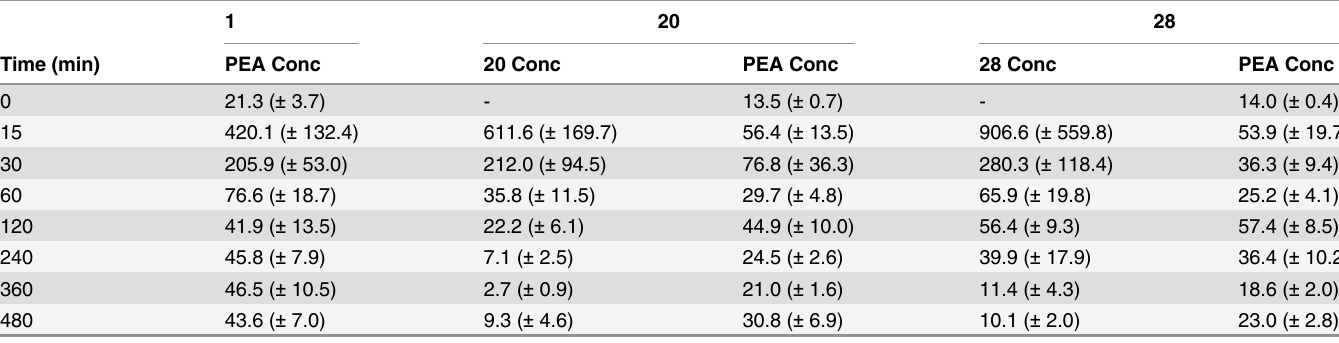
Table 2. Plasma concentrations (nM) after p.o. administration of PEA (1), 20 and 28.